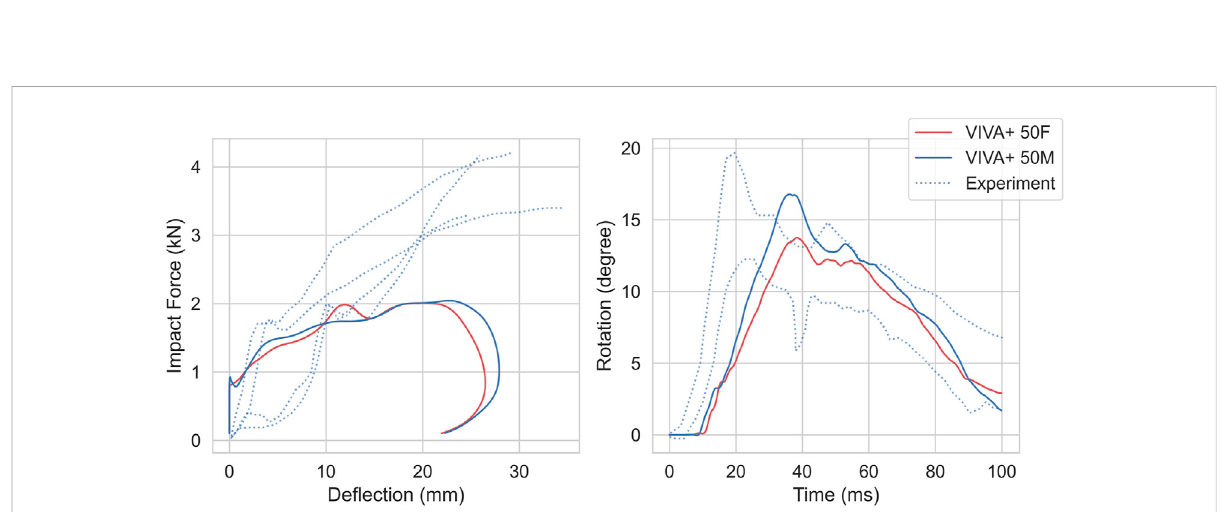
FIGURE 11 Kinetics and Kinematics for 1.5 m/s impact at T8, compared to Forman et al., 2015. (Left) Force-thorax deformation compared with the four PMHSresponses.(Right)T1-L3SpineRotationcomparedwithPMHS±onestandarddeviationresponses.Dottedlinesshowexperimentalresponses.